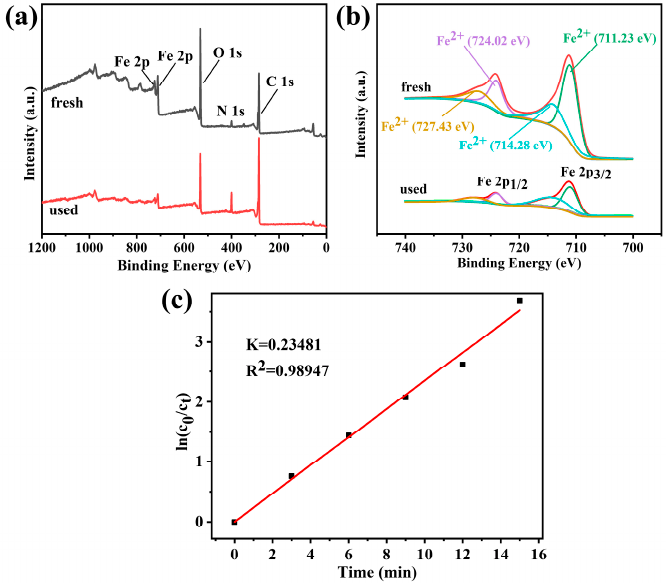
Figure 8. ( a ) The XPS survey spectral of the fresh and used-five-times composite catalyst; ( b ) spectra of Fe 2p; ( c ) pseudo-first-order kinetics of degradation of MB (FeC 2 O 4 content was 80%, pH 0 = 7, MB content was 10 ppm, H 2 O 2 content was 100 ppm, T = 2 °C).